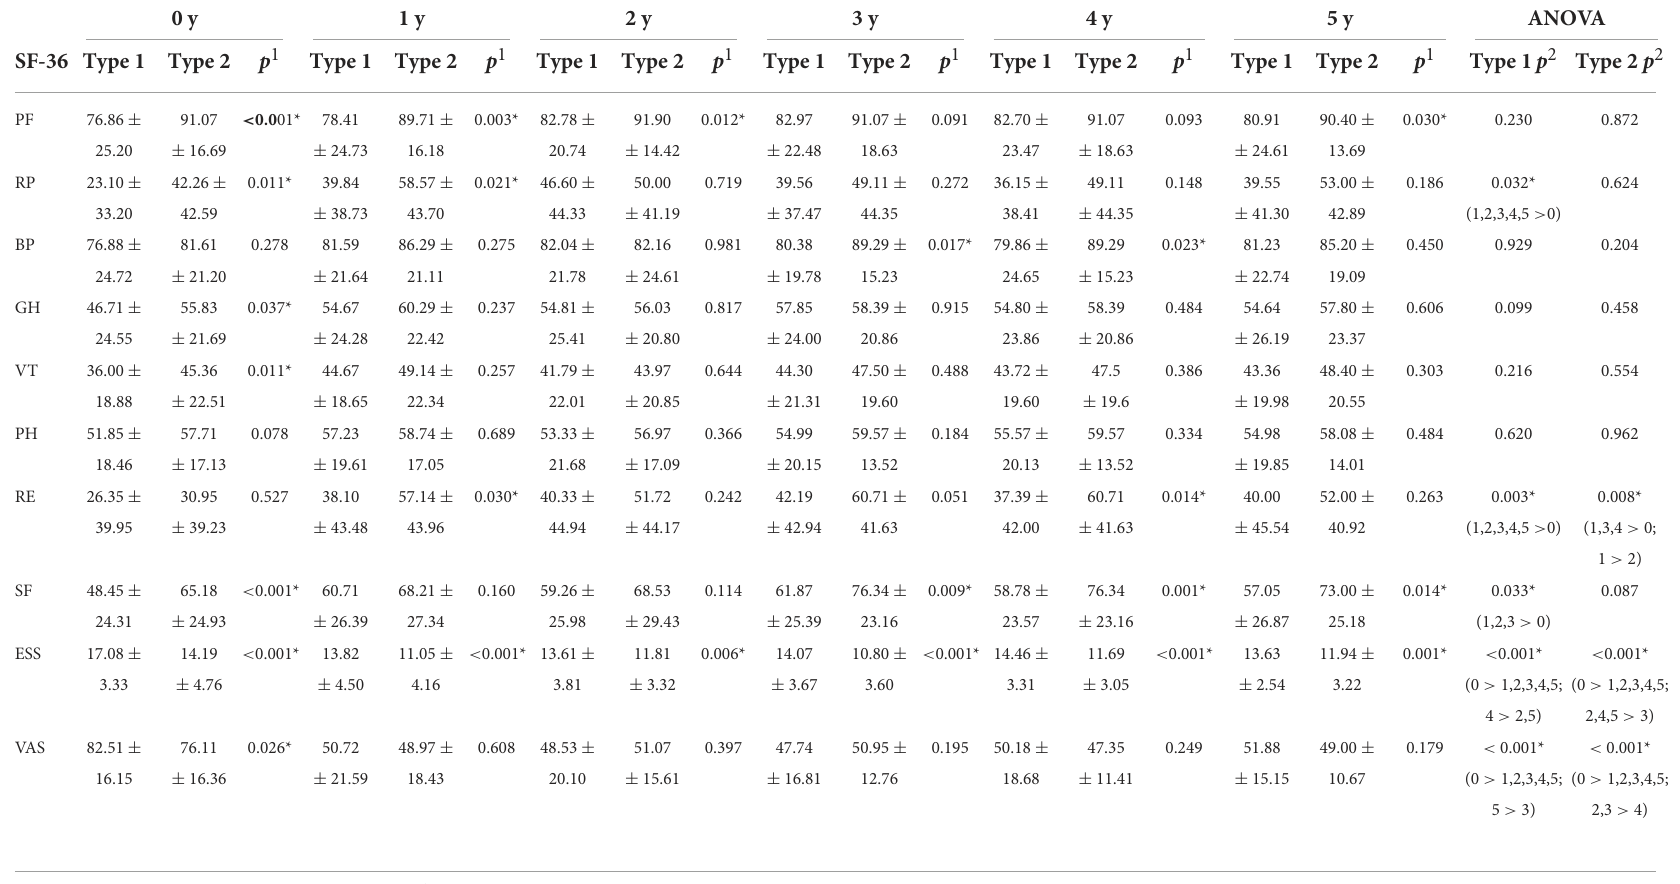
TABLE 2 Comparison of the data of SF-36, ESS and VAS of narcolepsy type 1 and type